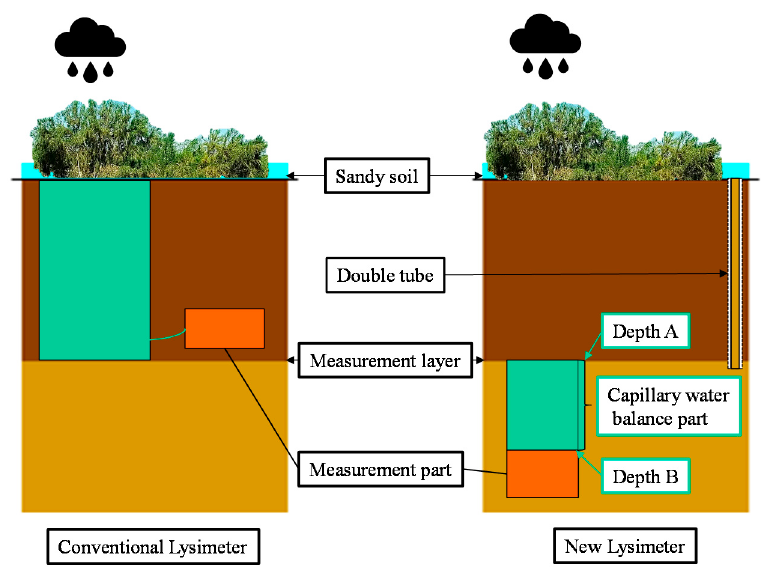
Figure 2. Schematic diagram of the recharge process of DSR observed via the newly designed Lysimeter. Left is the traditional Lysimeter; right is the newly designed Lysimeter. (The conventional Lysimeter has a massive semi-closed container in which plants are planted inside; the newly designed Lysimeter has a small shape, and the upper interface of this instrument is the measuring surface, which can be set in any depth of soil without the need for vegetation planted inside.)